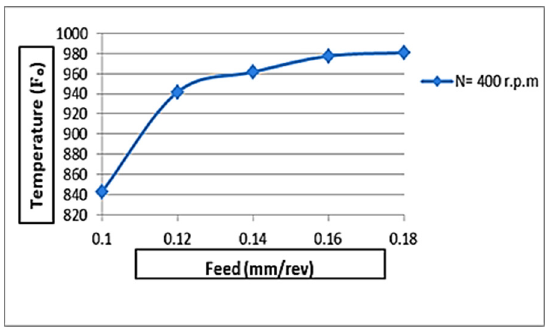
Fig. 9. Effect of spindle speed on temperature.